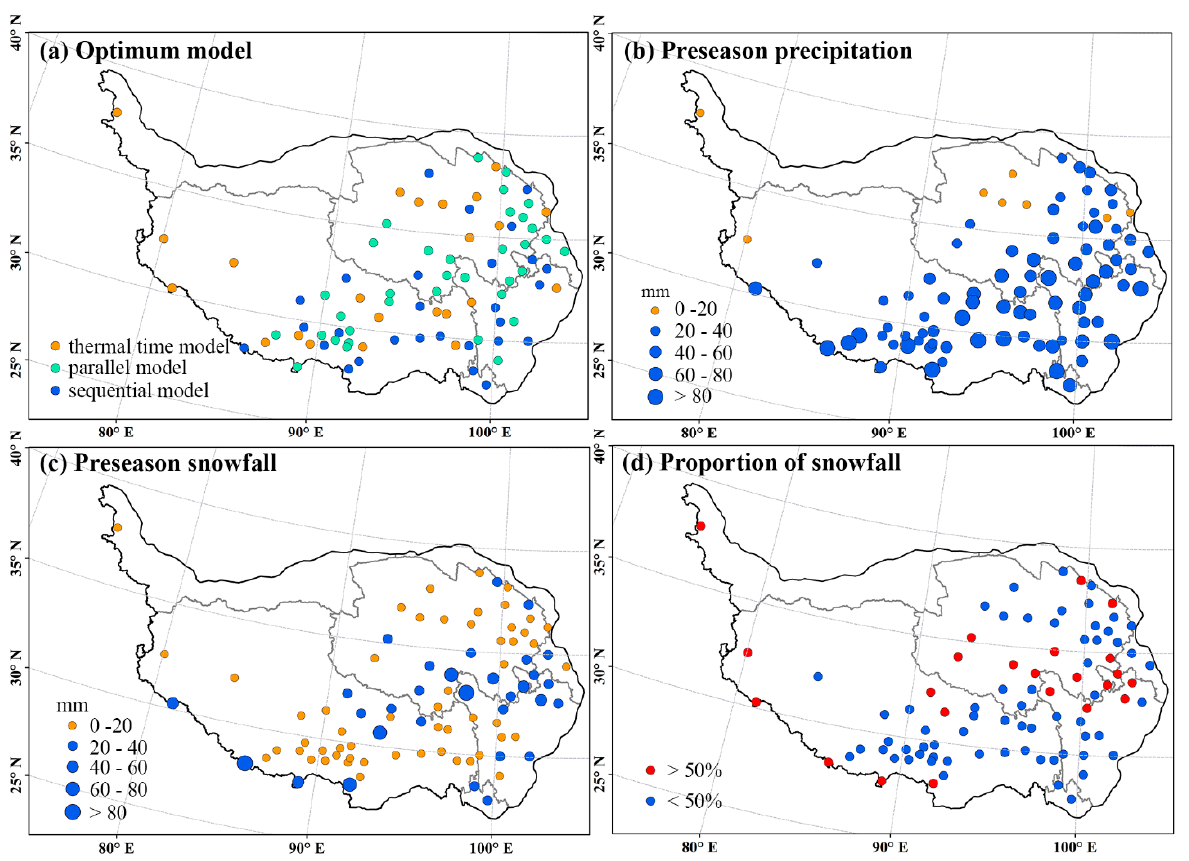
Figure 4. The optimum process-based models for land surface green-up dates and their annual mean preseason precipitation/snowfall in 86 meteorological stations. ( a ) Optimum model, ( b ) annual mean preseason precipitation from January to April, ( c ) annual mean preseason snowfall January to April, and ( d ) proportion of snowfall.